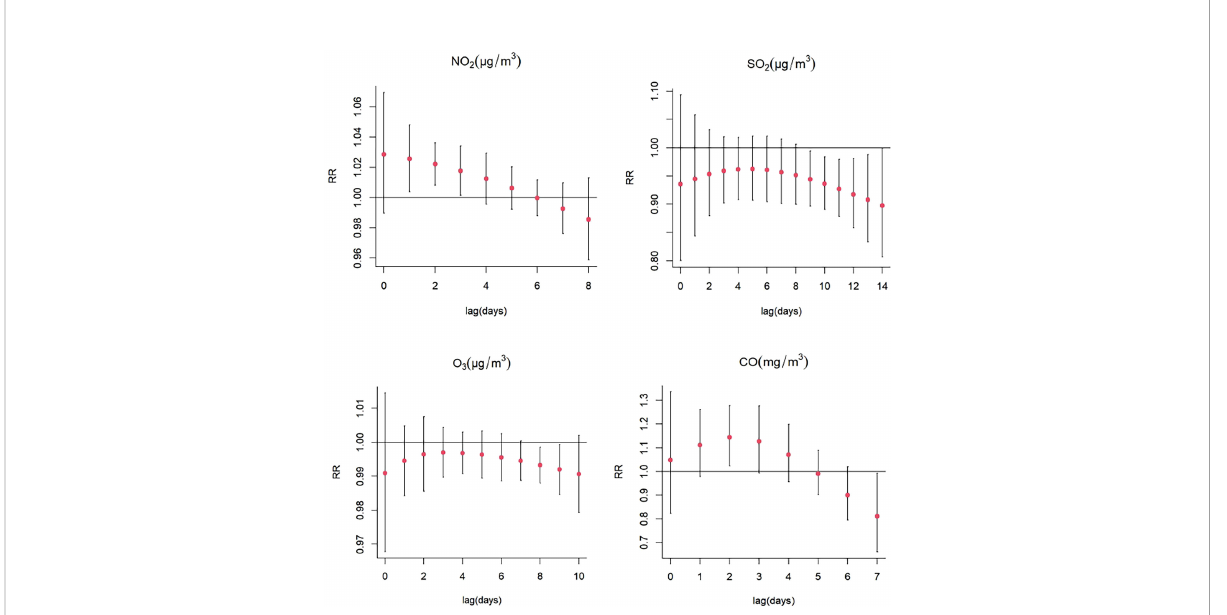
FIGURE 3 Lag-speci fi c relative risks (%) in hospitalizations for SS per 10 (or 1)-unit increase in daily mean concentrations of gaseous pollutants in the model.